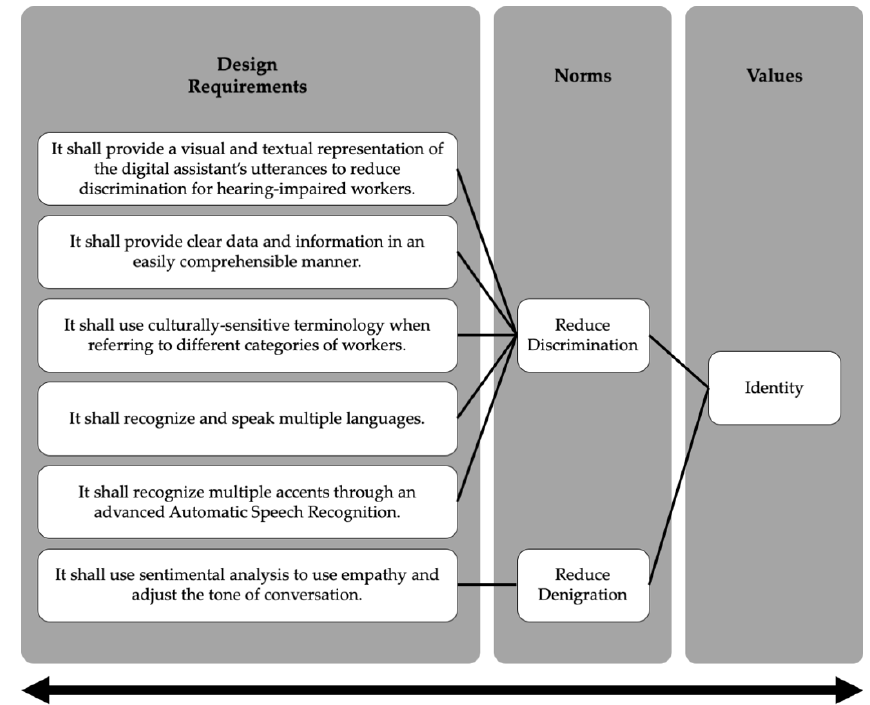
Figure 14. Bi-direction hierarchy showcasing how the value of identity can be extrapolated from technical design requirements through norms for voice-enabled digital assistants. 668